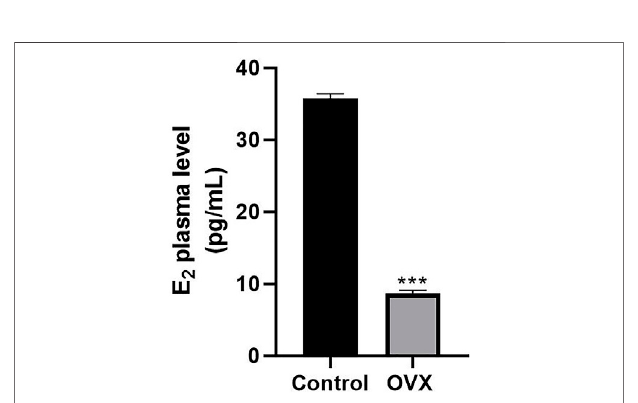
FIGURE 3 | ELISA results showing changes in serum estrogen levels in rats. One month after ovariectomy (OVX), the serum levels of estrogen were compared between the OVX group and the control group (*** p <